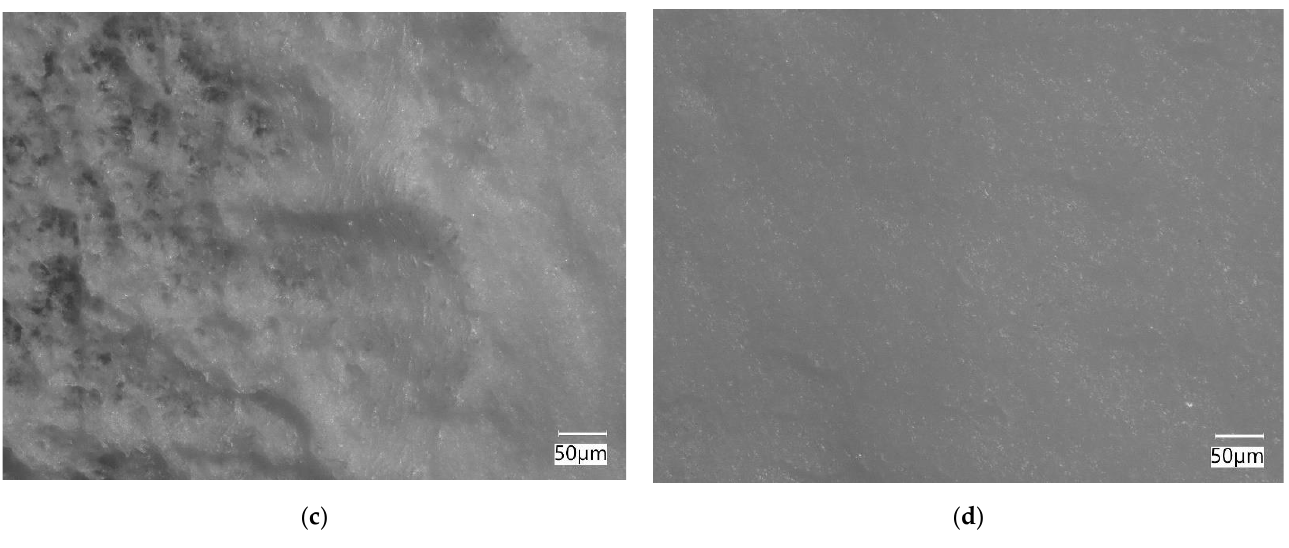
Figure 12. Images depicting the different crack growth mechanisms in a PP-1 specimen at ∆ K I of 1.09 MPa × m 0.5 . Overview image of specimen ( a ) the approximate positions of the three areas from fibrillation ( b ), transition ( c ), and large-scale brittle failure ( d ) are depicted with red rectangles.